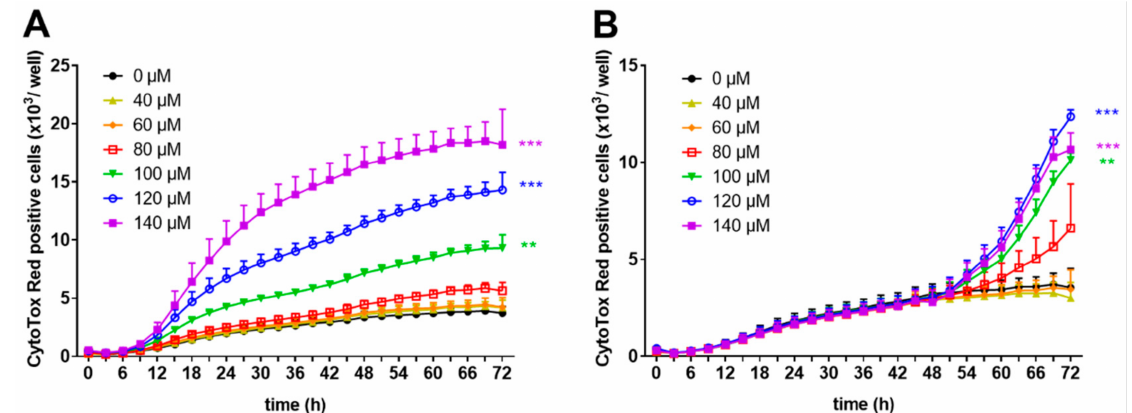
Figure 4. Zinc aspartate impaired membrane integrity of freshly stimulated and pre-activated T cells. Human resting T cells were freshly stimulated ( A ) or pre-activated for 48 h ( B ) with anti-CD3/CD28 antibodies and cultured with increasing concentrations of zinc aspartate. For kinetic analyses, T cells were cultured with increasing concentrations of zinc aspartate in the presence of CytoTox Red reagent. Kinetic measures of the number of CytoTox Red positive cells were recorded by the IncuCyte S3 imaging system at 3 h intervals for 72 h. Data are presented as the mean + SEM from three independent experiments (** p < 0.01, *** p <